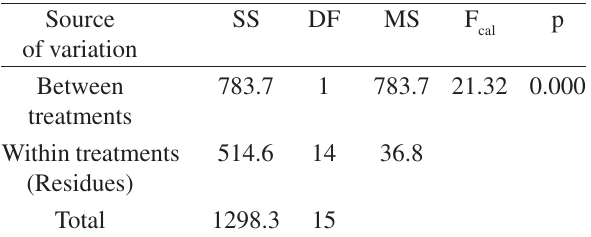
Table 3. Analysis of variance for the data of Table 2.